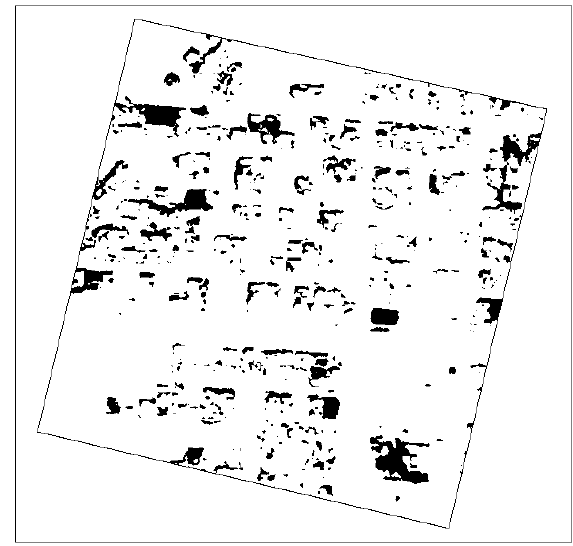
Figure 9. D-DSM as binary map after refinement by height